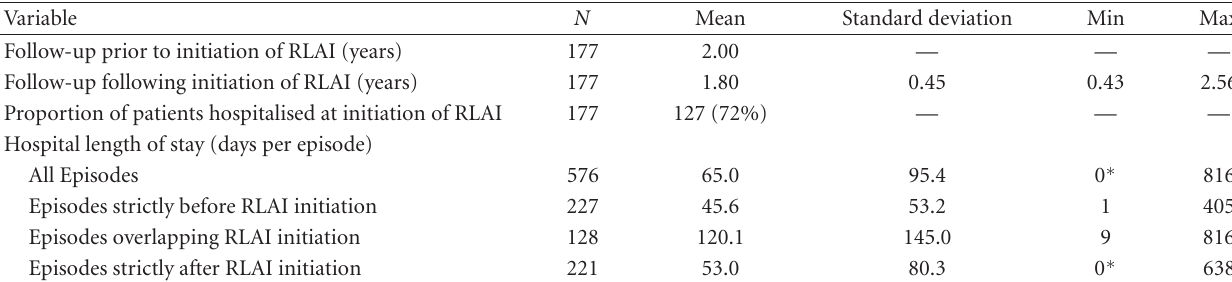
Table 2: Length of follow-up and of hospitalisation